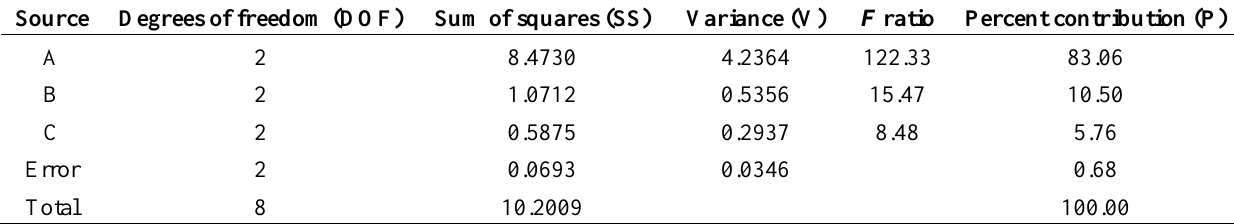
Table 5. Variance (ANOVA) Table for hardness.